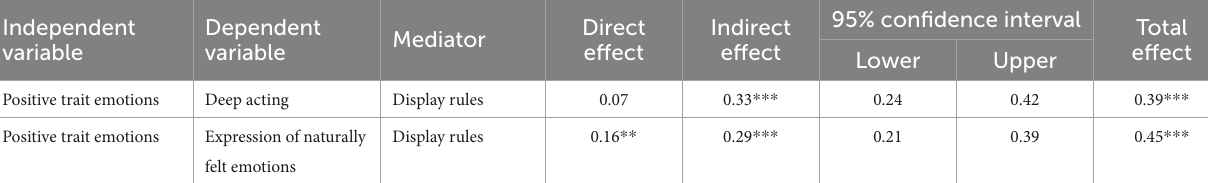
TABLE 3 Standard direct, indirect, and total effects of the 95% confidence intervals. Independent